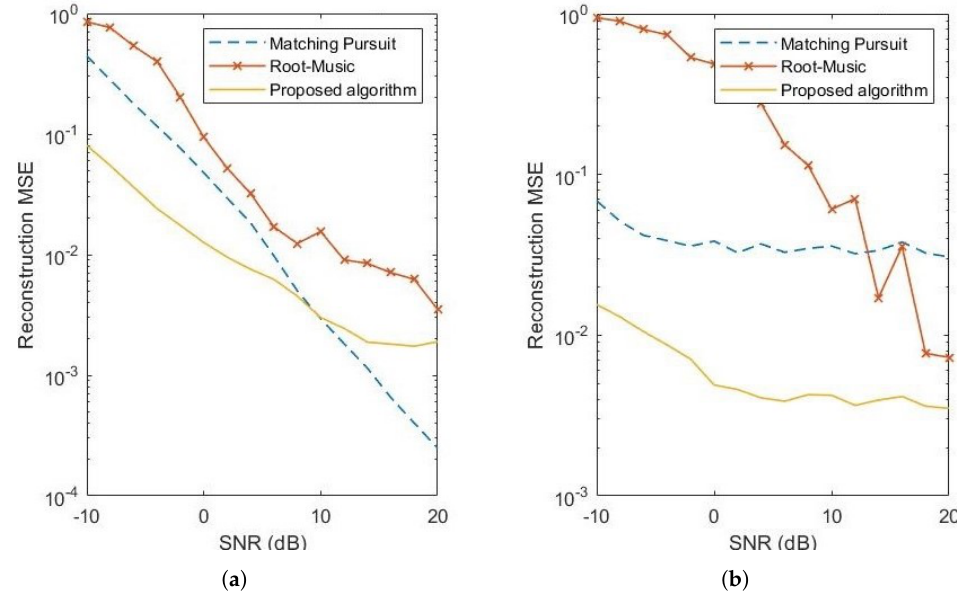
Figure 7. ( a ) Mean square reconstruction error against SNR for T = 1 s. ( b ) Mean square reconstruction error against SNR for T = 10 s.